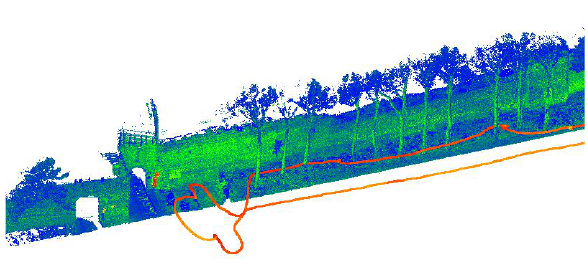
Figure 4. 3D point cloud generated by KAARTA Stencil 2 (©